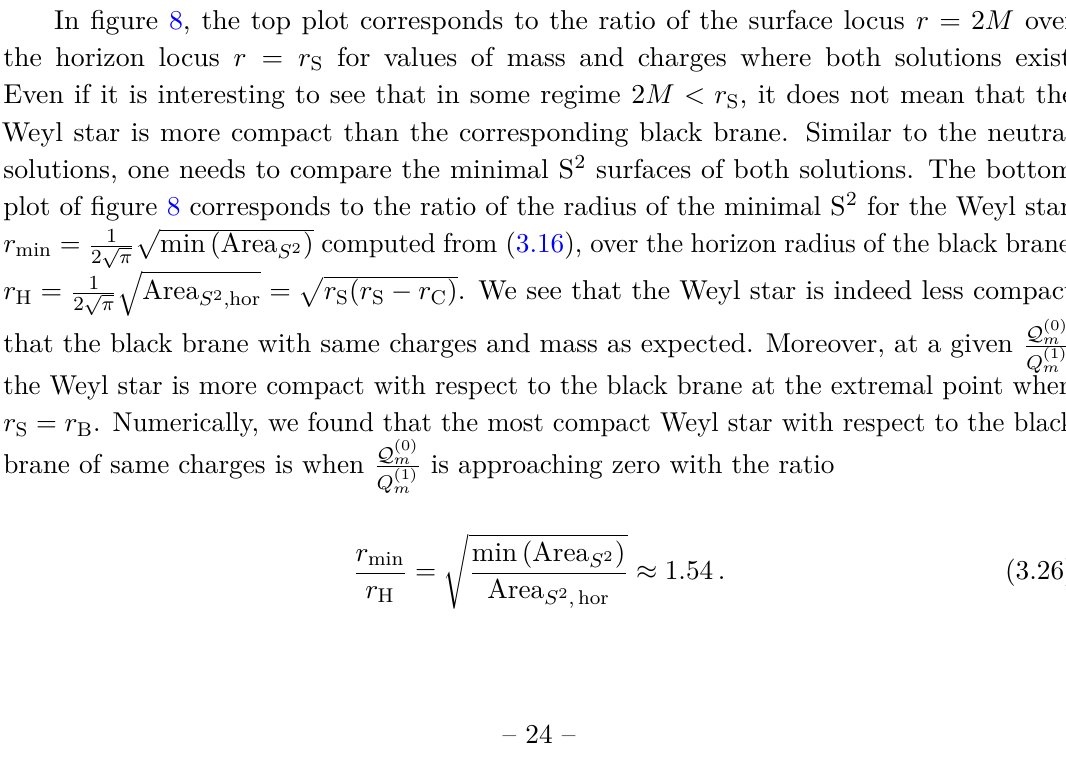
JHEP10(2021)165 . The plots Q (1) m = r S B